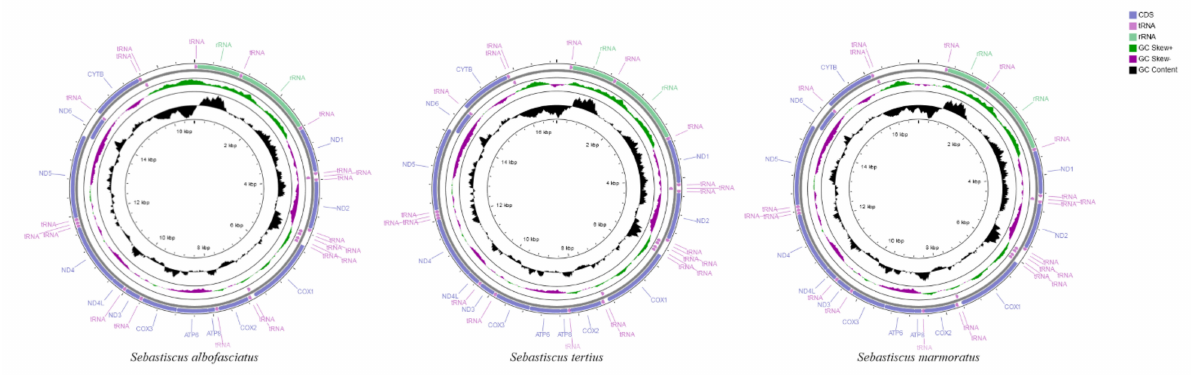
Figure 5. Mitochondrial genome maps of S. tertius , S. albofasciatus , and S. marmoratus . Genes encoded on the heavy or light strands are shown outside or inside the circular gene map, respectively.